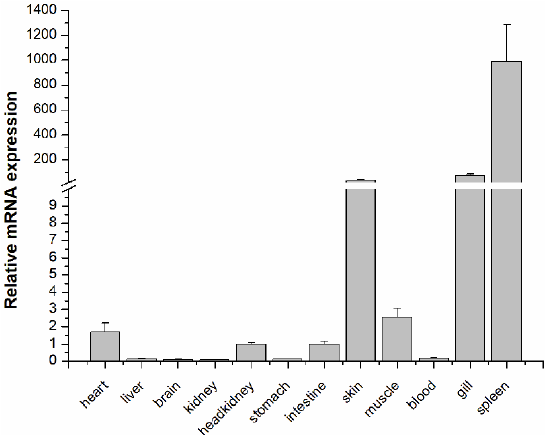
Figure 2. Tissues distribution of LcASC . The relative expression profile of LcASC was examined by qPCR and normalized against β -actin. Replications ( n = 5) were performed in each isoform and displayed as mean ± S.D.